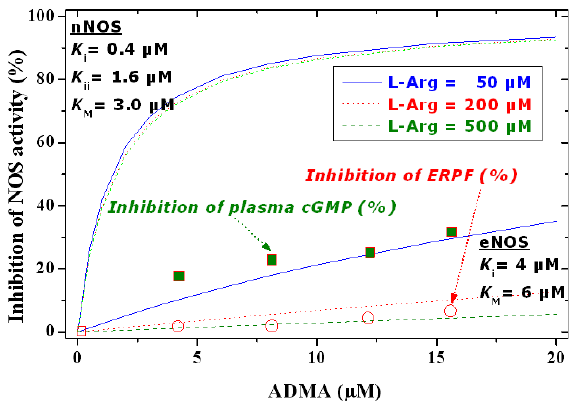
Figure 4. Calculated (curves) dependence of the extent of inhi- bition of eNOS and nNOS by ADMA (0 – 20 μ M) at three fi xed concentrations of L-arginine (i.e., 50, 200, and 500 μ M). The extent of inhibition was calculated by using the experimentally observed Michaelis – Menten kinetics con- stants in the present study for eNOS and in previous work for nNOS (KM = 6 μ M for eNOS and 3 μ M for nNOS; Ki = 4 μ M for eNOS and 0.4 μ M for nNOS; Kii = 1.6 μ M for nNOS) (3, 23, 24). Open squares and circles are experi- mentally observed data on the extent of inhibition of plasma cGMP and ERPF upon infusion of ADMA and are indicated by arrows.